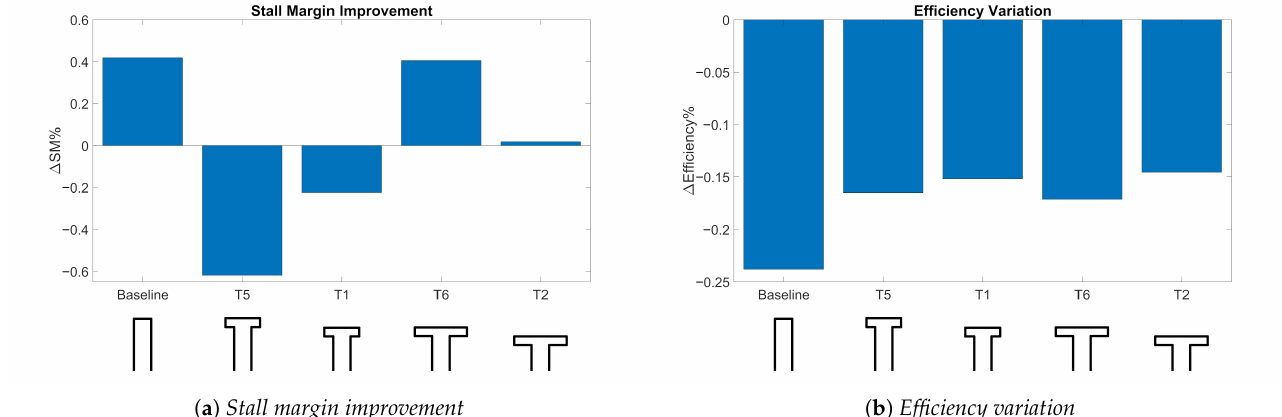
Figure 19. Groove